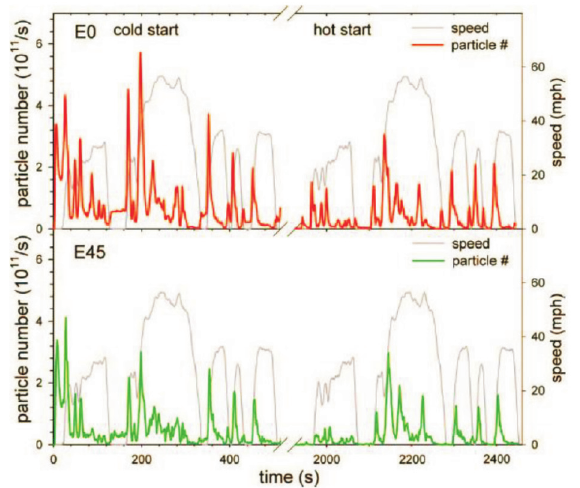
Fig. 4. Exhaust emissions of CO from an unmodified car running over the NEDC on various ethanol blends [27]